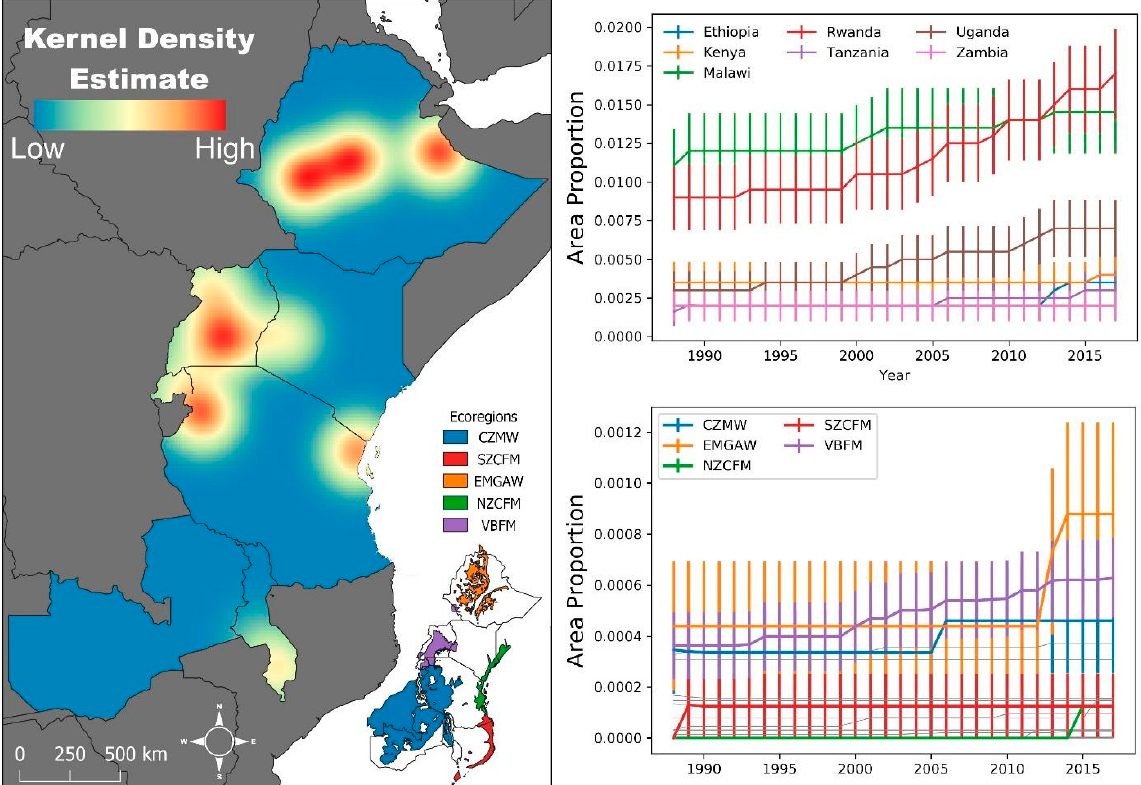
Figure 6. Settlement gain in East Africa. Left: Kernel Density hotspot analysis of new Settlements. Top, proportional change of Settlements in seven countries. Bottom, Proportional change of Settlements in ecoregions in which the five ecoregions with the greatest change are colored (CZMW, Central Zambezian Miombo Woodlands, VBFM, Victoria Basin Forest-Savanna Mosaic, SZCFM, Southern Zanzibar-Inhambane Coastal Forest Mosaic, NZCFM, Northern Zanzibar-Inhambane coastal forest mosaic, EMGAW, Ethiopian montane grasslands and woodlands). The grey lines represent the other ecoregions.